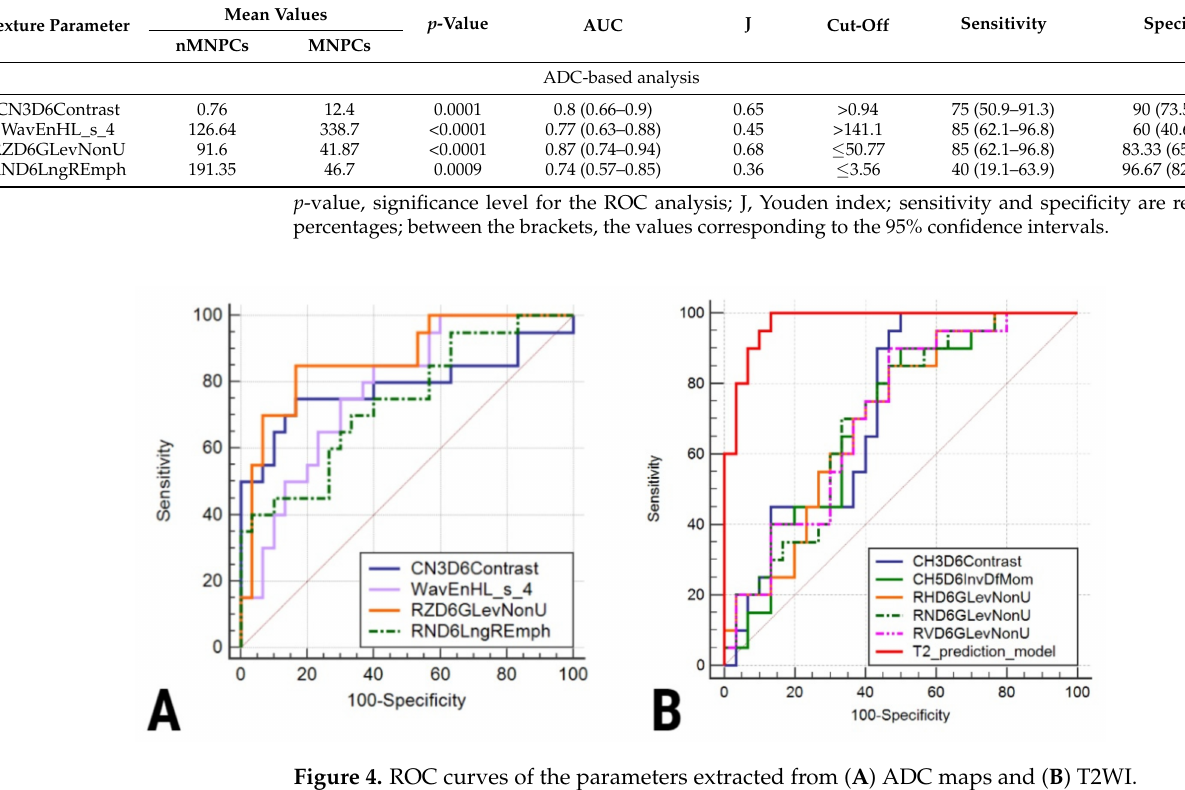
Figure 4. ROC curves of the parameters extracted from ( A ) ADC maps and ( B ) T2WI.